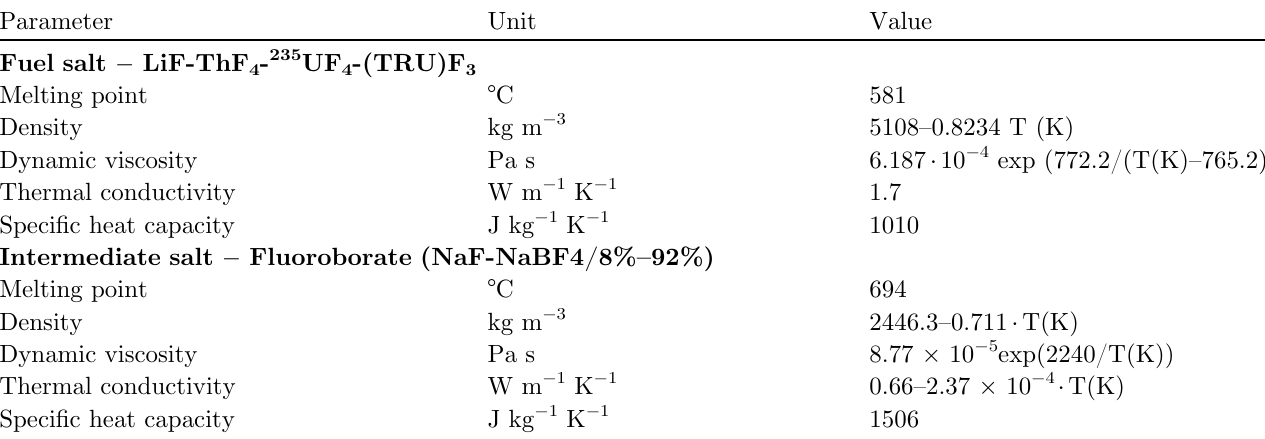
Table 1. Physical properties of fuel and intermediate salt [23,24]. Parameter